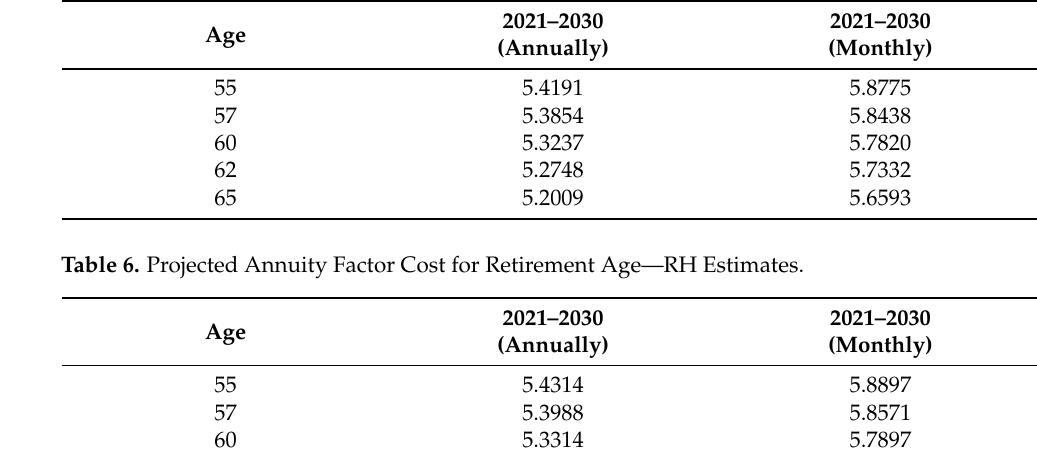
Table 5. Projected Annuity Factor Cost for Retirement Age—LC Estimates.